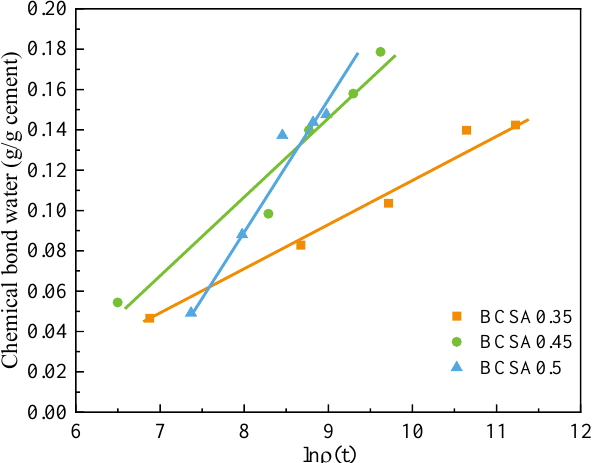
Figure 11. Correlation between chemically bound water and electrical resistivity of BCSA pastes with various w / c ratios.